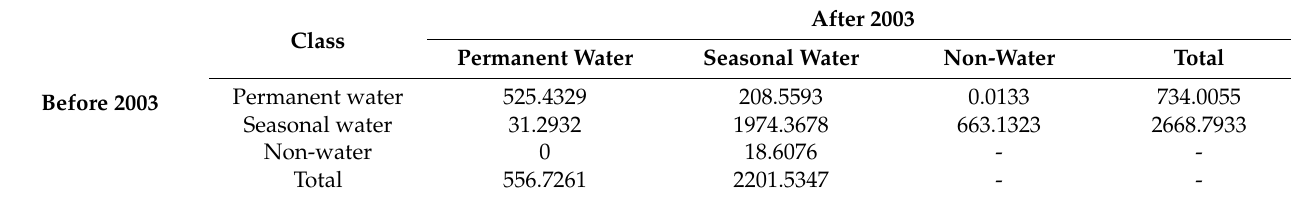
Figure 8. Permanent and seasonal water changes in Dongting Lake. Table 9. Accuracy verification confusion matrix. Unit (km 2 ).